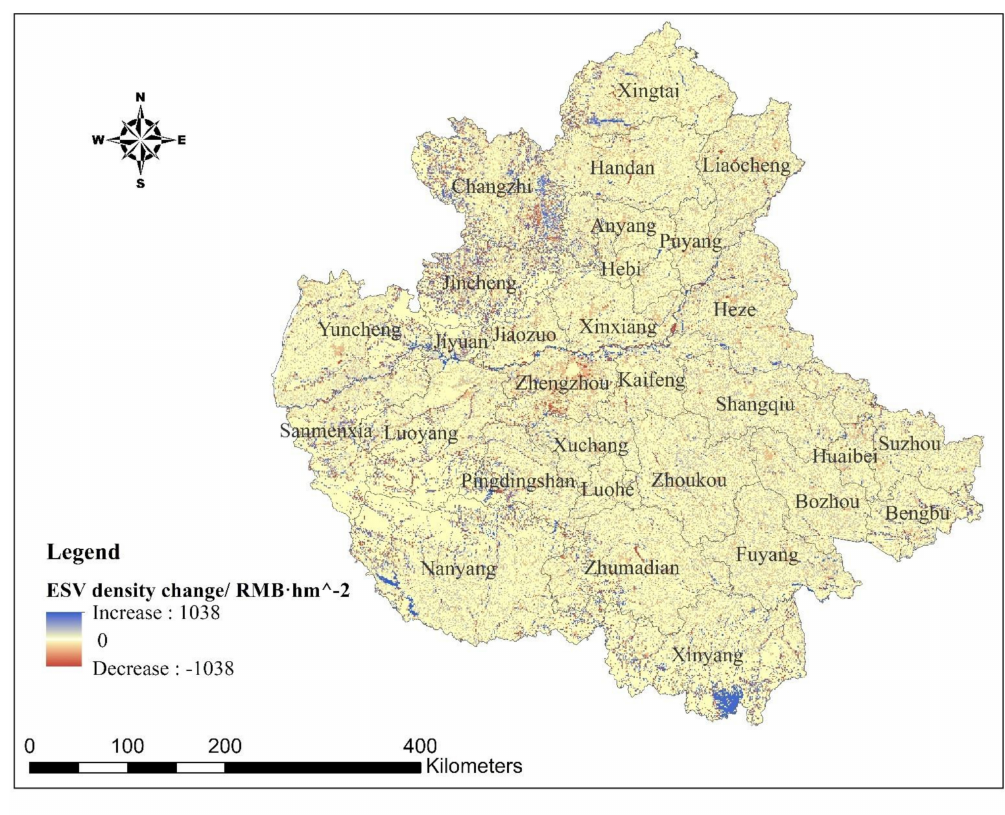
Figure 3. Distribution and its change of ESV density of cities in the Central Plains Urban Agglomeration in 2000 and